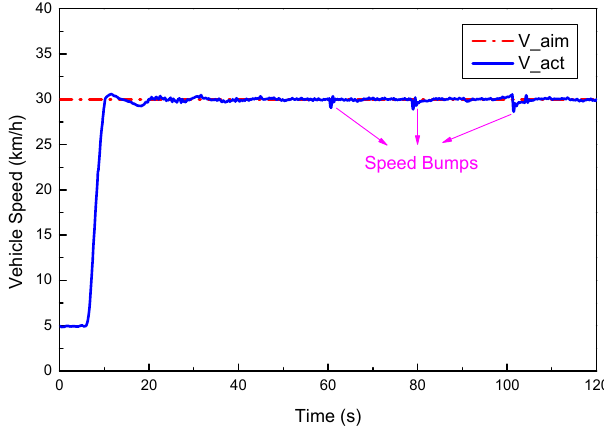
Figure 16. Longitudinal velocity tracking on roundabout.